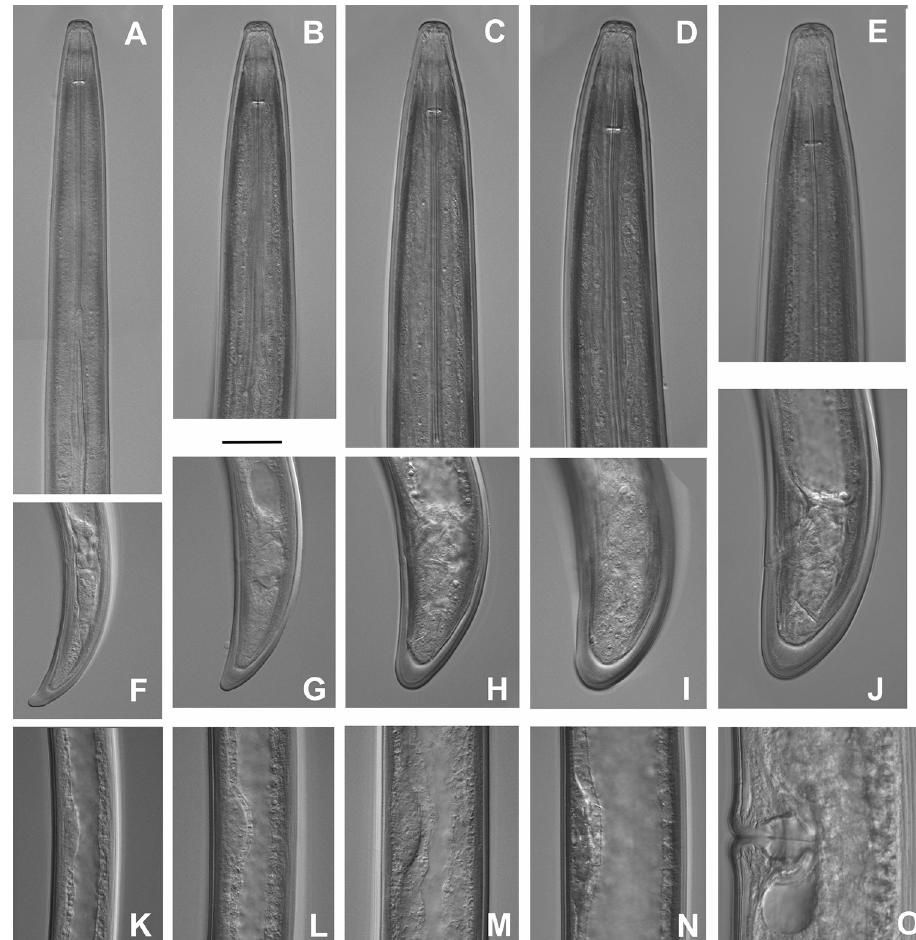
Figure 6. Longidorus piceicola Juveniles and female from Bran locality: A–E Anterior ends of first- to fourth-stage juveniles and female F–J Tails of first to fourth juvenile stages and female K–M Genital primordium of first to fourth juvenile stages. O Vagina. Scale bar: 20